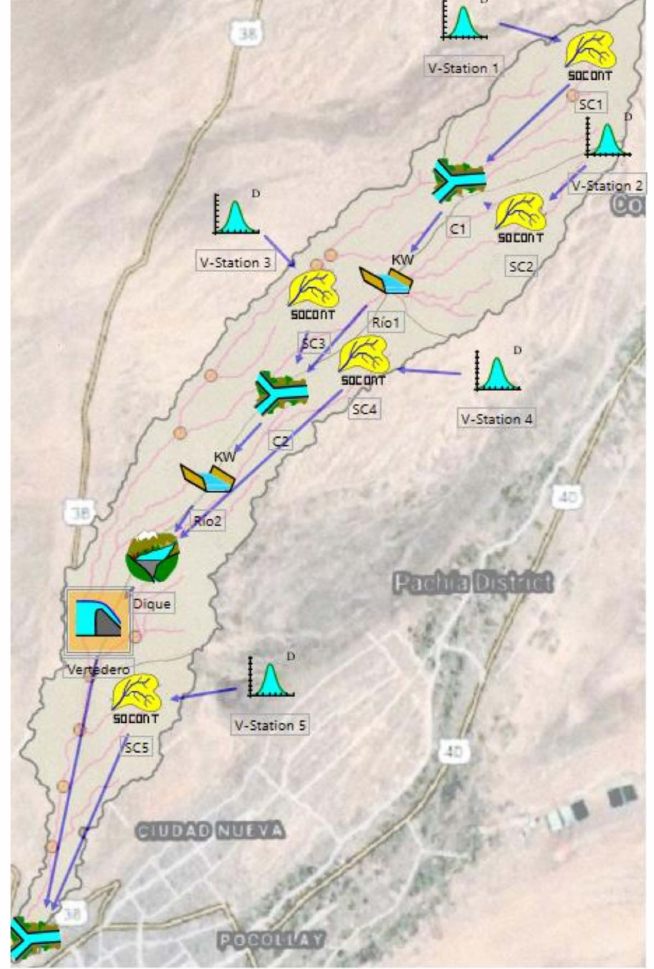
Figure 29. Structure of the RS Minerve Model for simulation of the 21 February 2020